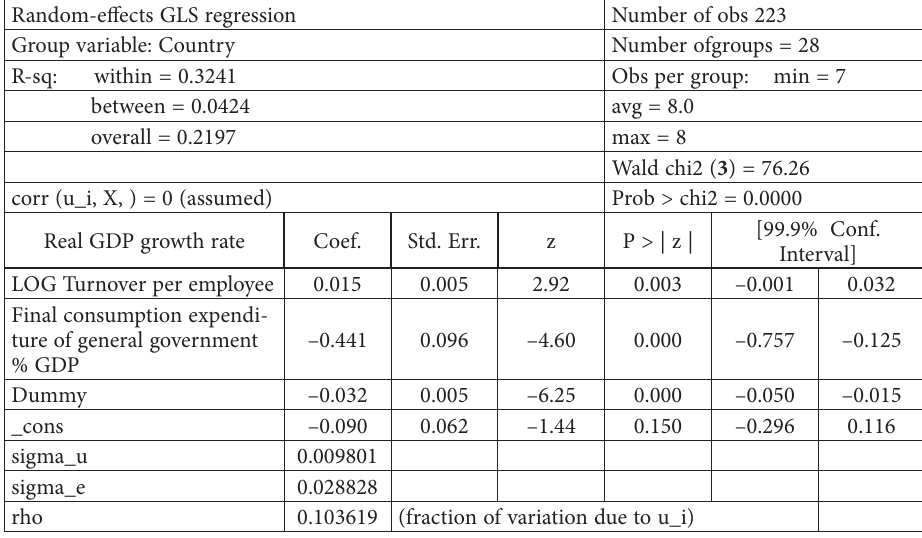
Table 4. Regression using random effect (source: authors’ calculations) Random-effects GLS regression